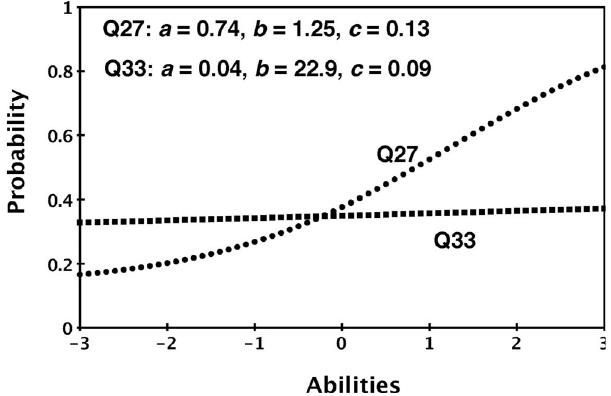
FIG. 13. Item characteristic curves for two MIET items (cid:1) Q27 and Q33 (cid:2) .